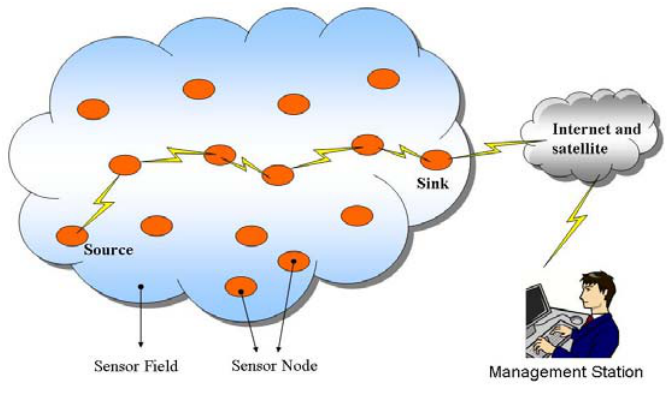
Figure 1. Communication architecture of sensor